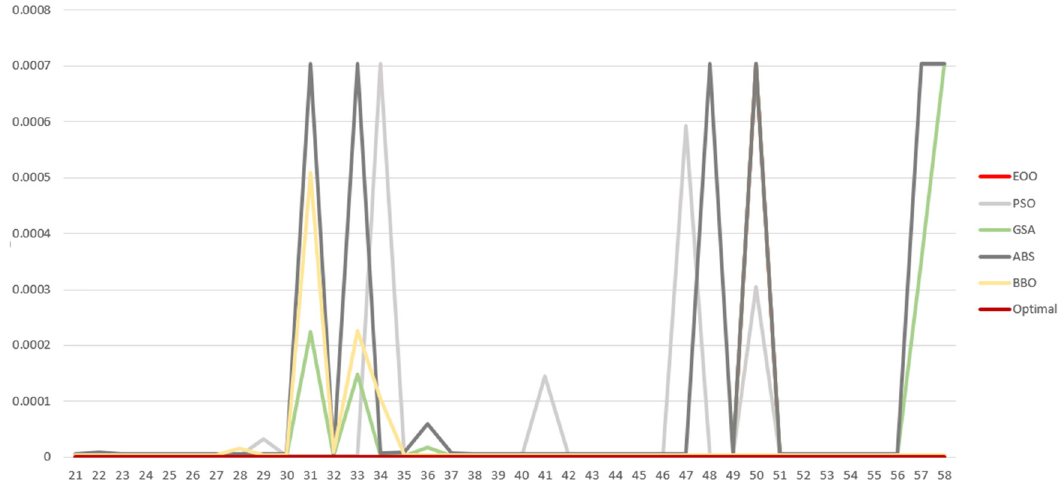
Figure 4: A comparison of the optimal value of the multimodal function test with results of the proposed EOO, PSO, GWO, BBO, GSA, and ABC algorithms